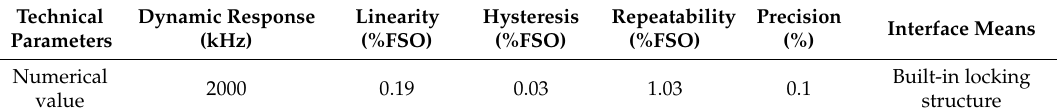
Table 4. Earth pressure sensor and pore water pressure sensor parameters.